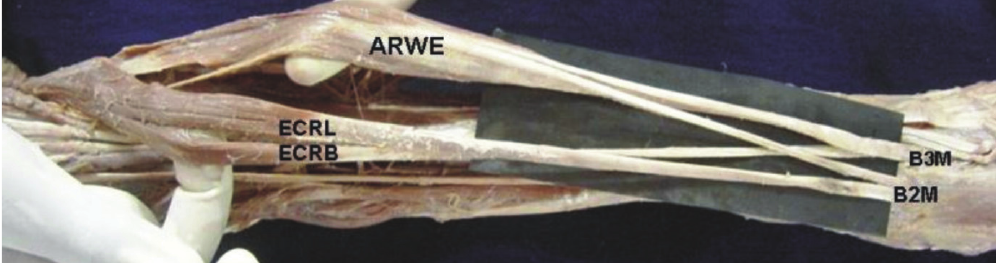
Figure 2 - Extensor compartment of the left forearm and hand region. ARWE, additional radial wrist extensor; B2M, base of the second metacarpal bone; B3M, base of the third metacarpal bone; ECRL, extensor carpi radialis longus.